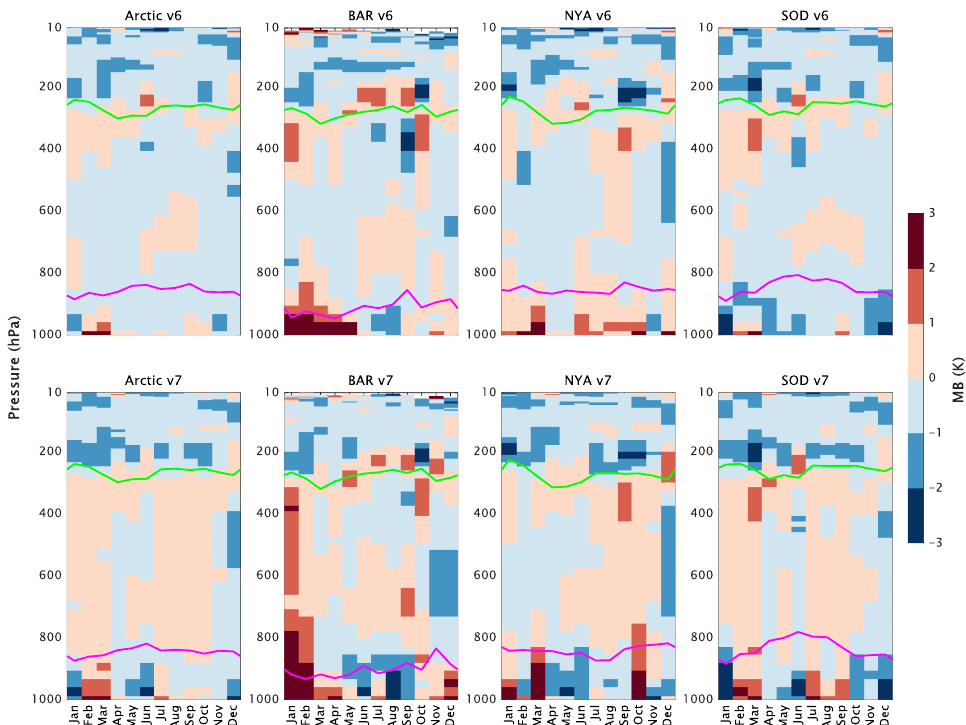
Figure 4. Seasonal variation in the mean bias profiles for AIRS v6 and v7 and the 3 GRUAN Arctic sites and their average using data from 2012 to 2016. Data are grouped into 12 bins, and the results are presented as a function of pressure at each bin’s center point. The green and magenta lines show the pressure of the tropopause and boundary layer top estimated from AIRS retrievals, respectively. The result is statistically significant ( t -test, p < 0.05).